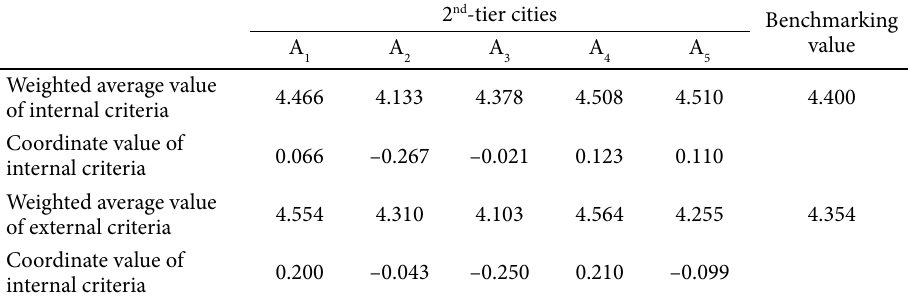
Table 13. Coordinate values of 2 nd -tier cities in China under SWOT analysis